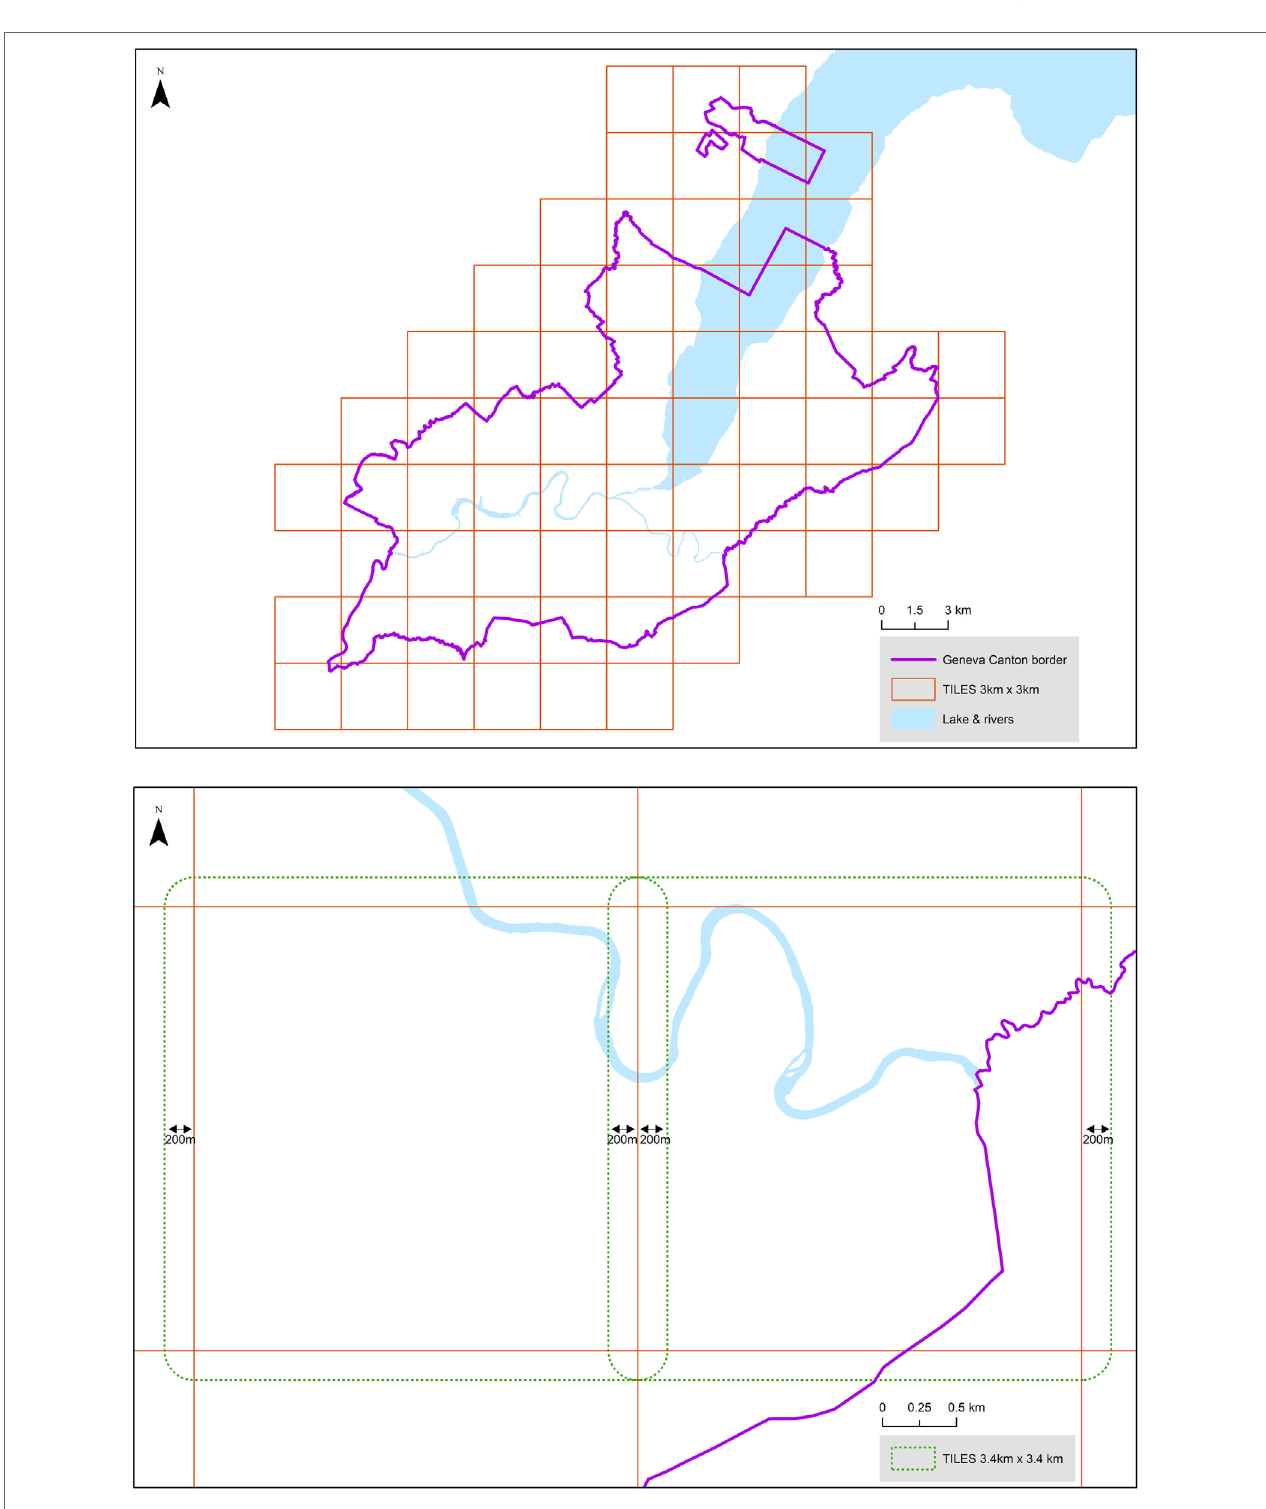
FIGURe 5 | Splitting the Canton of Geneva in tiles of 3 km × 3 km (top); adding a buffer of 200 m to each tile avoiding possible mutual shadowing effects